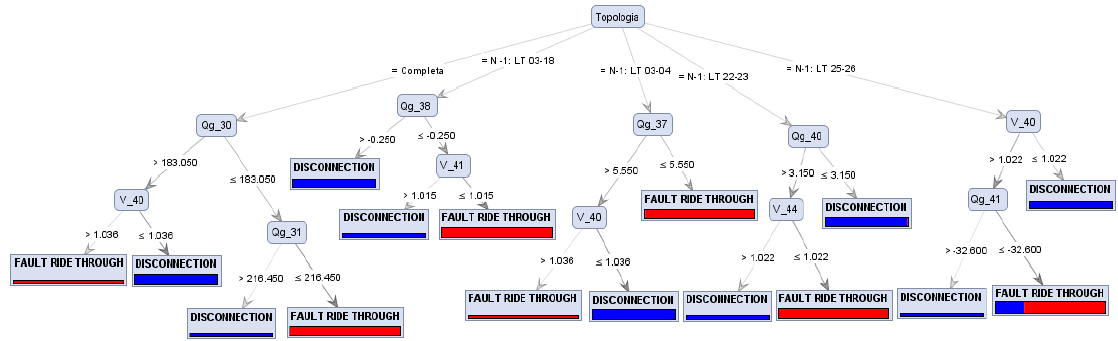
Figure 10. Decision tree for the application of preventive control during systemic actions.